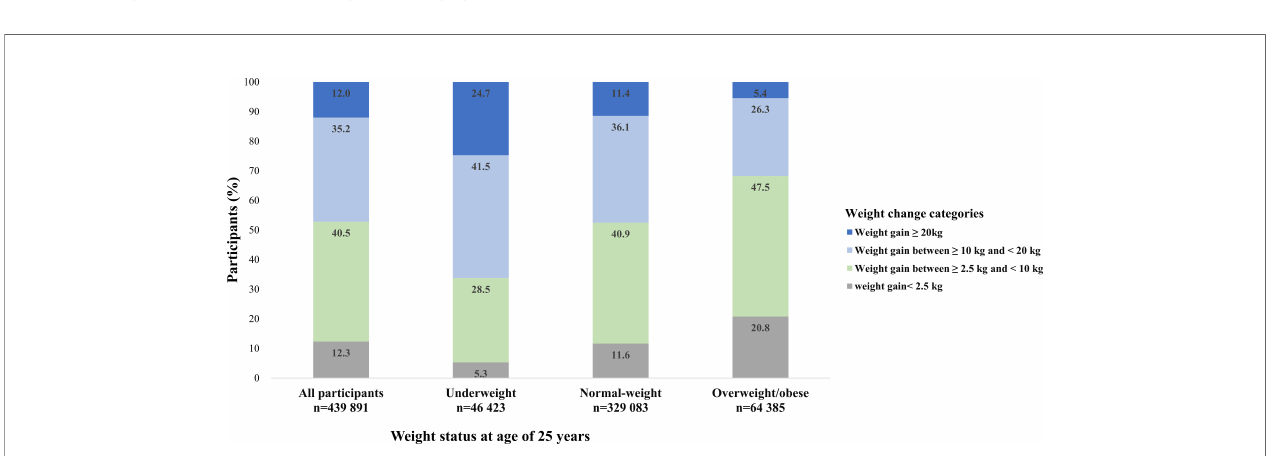
FIGURE 1 | Distribution of weight change categories by BMI categories at young adulthood.